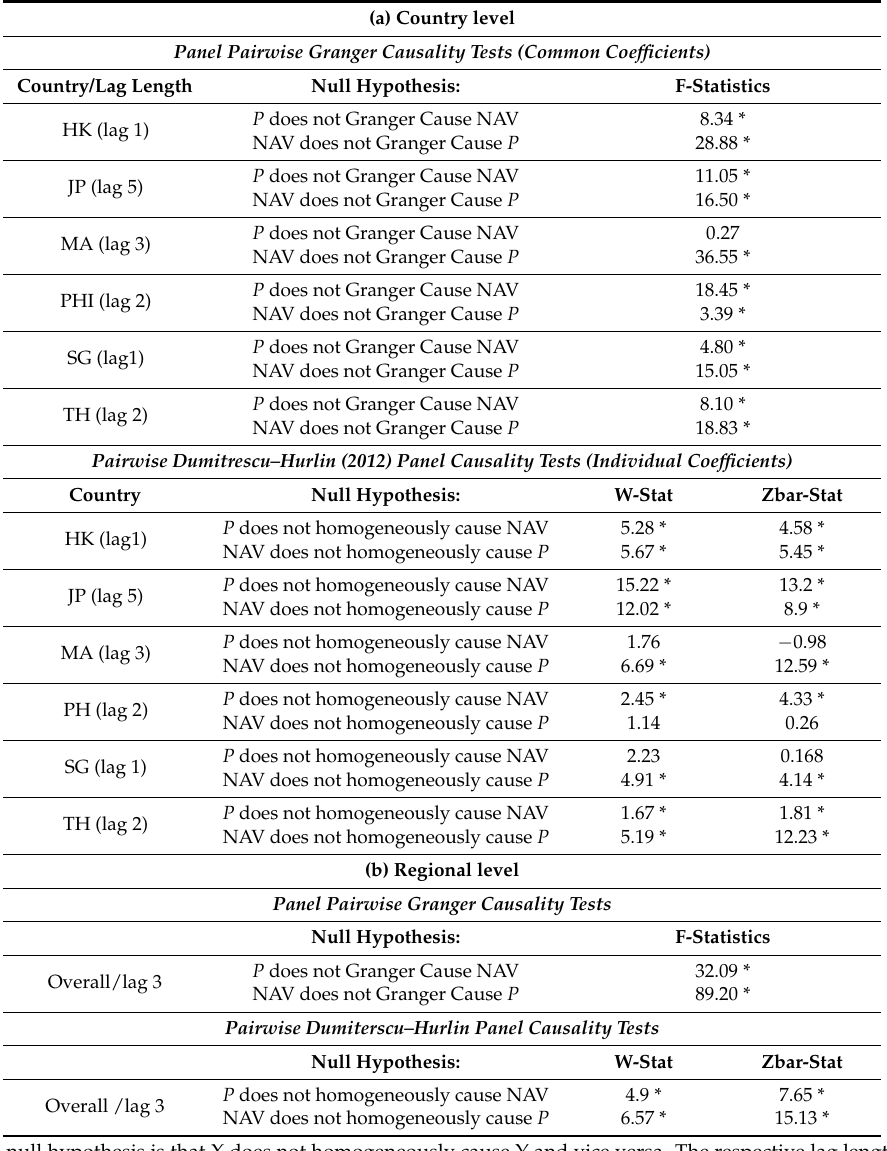
Table 5. Results for Granger panel causality test between P and NAV: